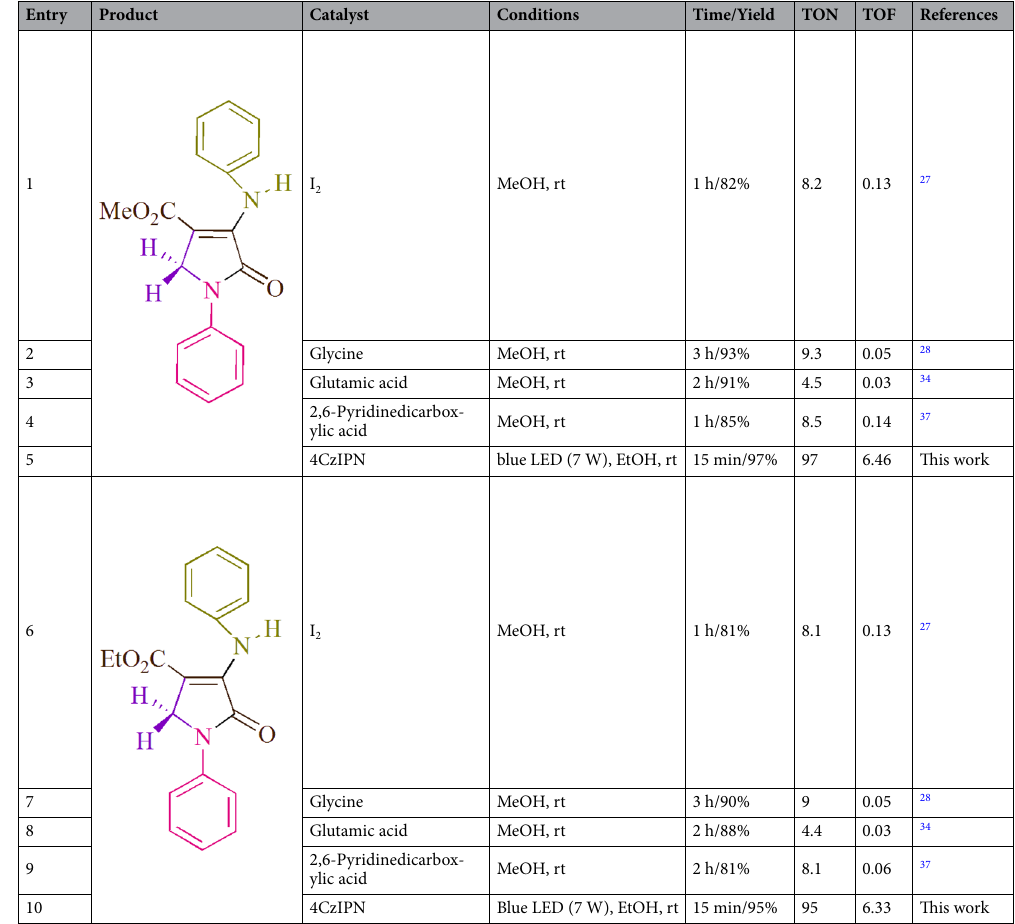
Table 5. Analysis of the catalytic ability of the numerous catalysts in the text leads to the synthesis of 5a and 5b a . a Four-components are used in the synthesis: aniline, dimethyl/ethylacetylenedicarboxylate, and